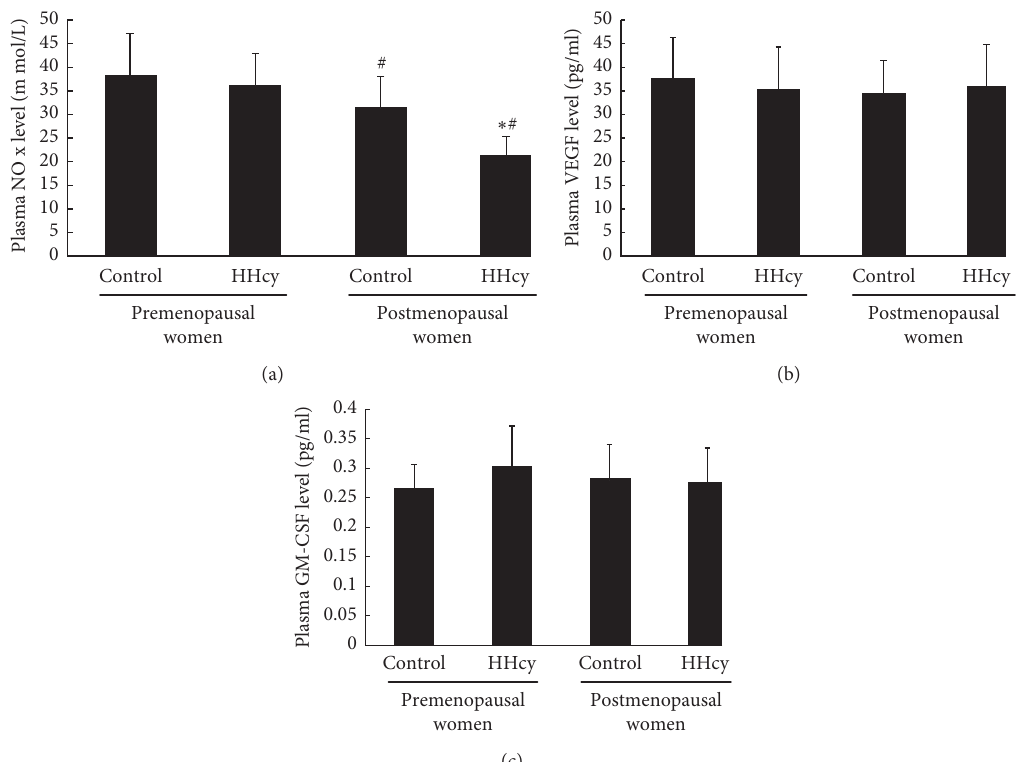
Figure 3: The plasma NO, VEGF, and GM-CSF levels in the four groups were shown as follows. (a) The plasma NO level in postmenopausal women was lower than that in premenopausal women. The plasma NO level in hyperhomocysteinemia postmenopausal Women was lower than that in control, but there was a similarity in control and hyperhomocysteinemia premenopausal women. (b) There was no significant difference in the plasma VEGF level between the four groups. (c) There was no significant difference in the plasma GM-CSF level between the four groups. Data are given as mean ± SD. ☆ vs. control; # vs. premenopausal